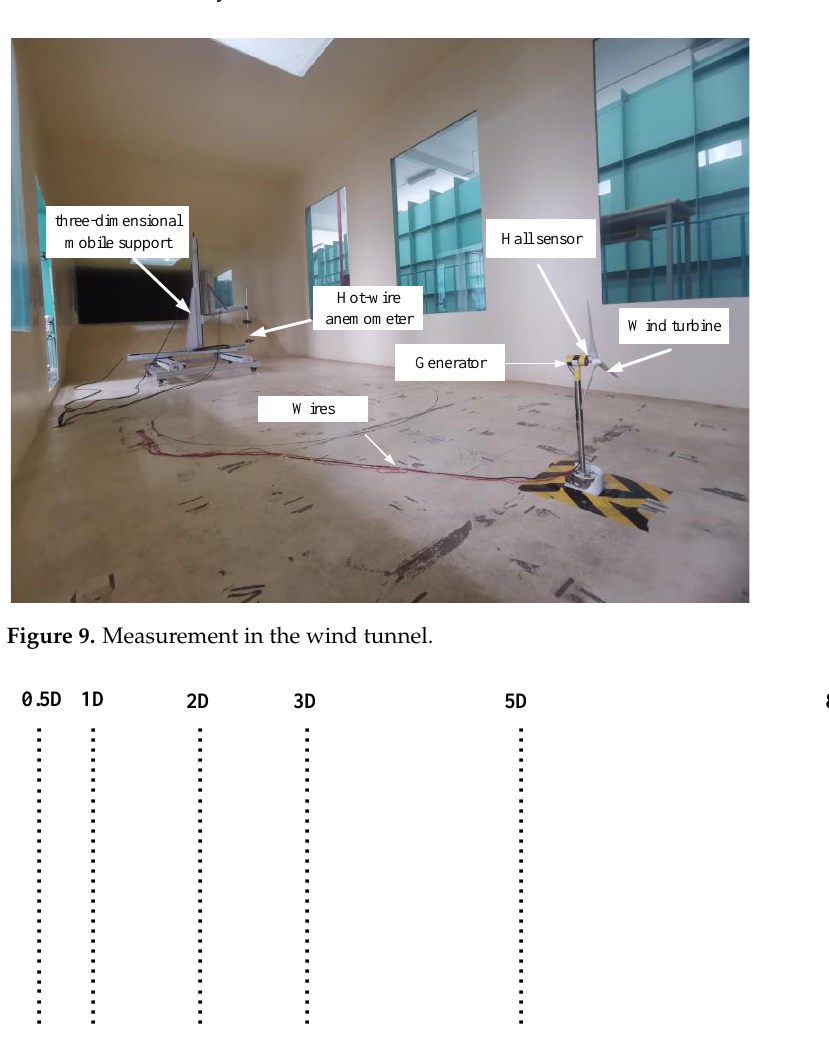
represented in Figure 9. The test measuring points were distributed in the horizontal plane at hub heights 0.5D, 1D, 2D, 3D, 5D, and 8D behind the wind rotor (where D is the rotor diameter). One measuring point was arranged every 1 cm with the hub as the center. from the hub center to both sides to 30 cm, and 61 measuring points were arranged at each at hub heights of 0.5D, 1D, 2D, 3D, 5D, and 8D after the rotor, and the spacing between the adjacent measurement points was 1 cm. Besides, stochastic uncertainties may occur in the measurement due to the discretization of the instantaneous velocities. However, according to the experimental configuration in Ref. [33], the stochastic uncertainties can be overcome by a large number of samples (the sampling rate and numbers were 1 kHz and 65,536). Hence, to ensure accurate analysis, the sampling rate and numbers were set at 5 kHz and 100,000 in this study.